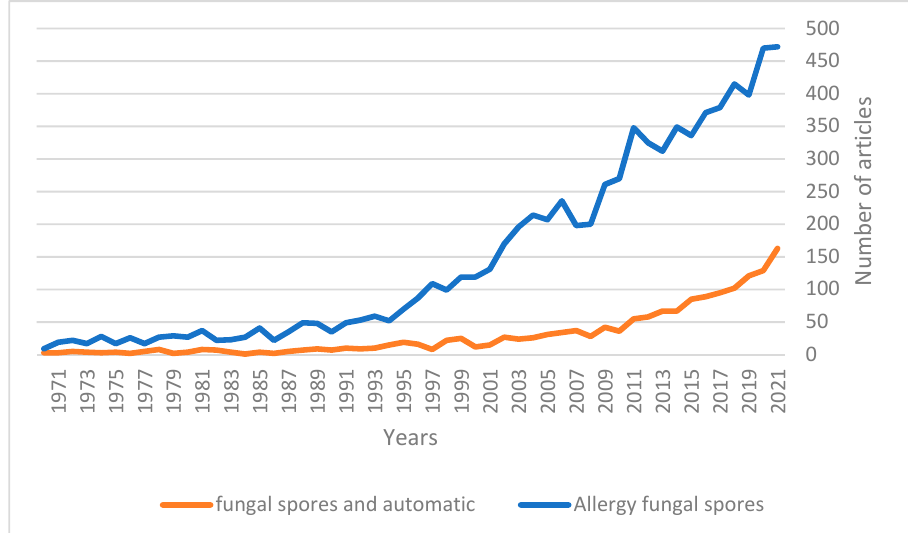
Figure 1. Comparison between articles published with search terms “allergy and fungal spores” and “fungal spores and automatic” in the last 50 years (source Scopus December 2021).